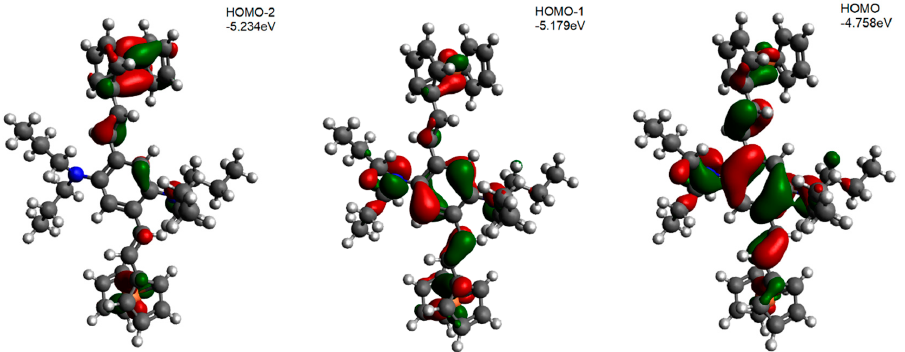
Figure 4. Occupied frontier orbitals: HOMO-2, HOMO-1 and HOMO.